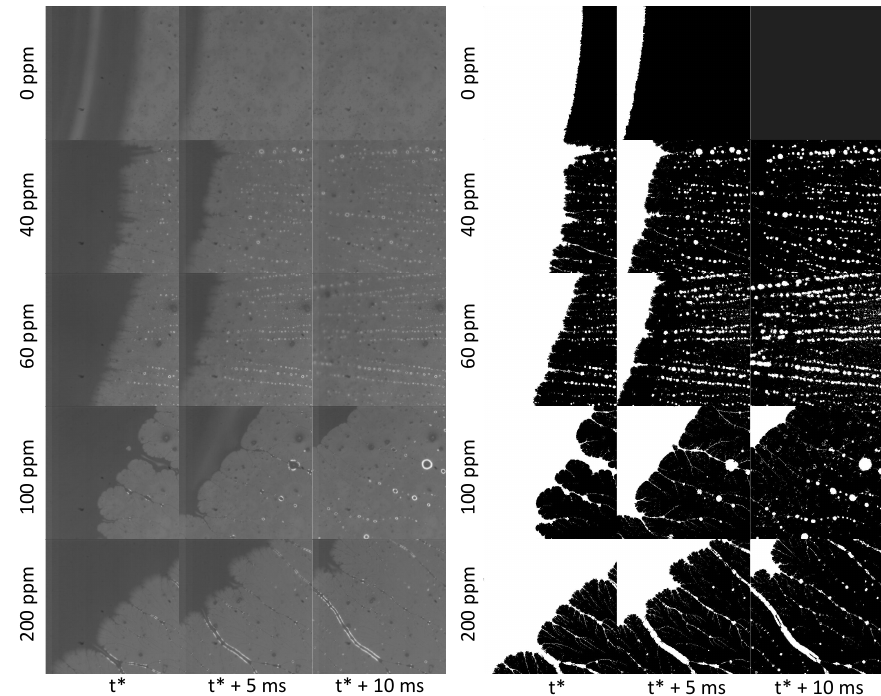
Figure 1. Microscopic contact line morphology during drop retraction on a hydrophobized glass substrate for different concentrations of PEO and impact Weber number We ≈ 110. ( Left panel ): raw images; ( right panel ): the same images enhanced by background subtraction, histogram equalization and conversion to binary. Each frame has a size of 700 µ m. See original videos in supplementary